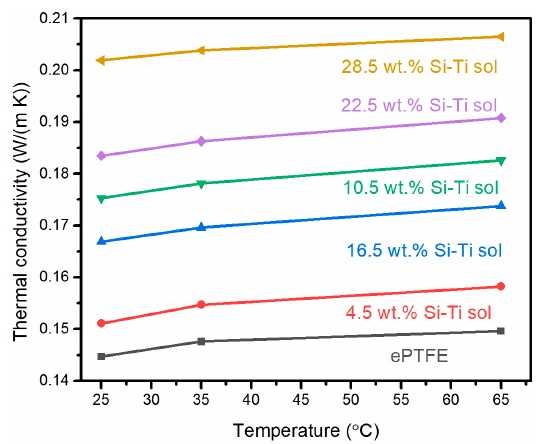
Figure 7 . The thermal conductivity of MSQ aerogel-layer-coated ePTFE film with different Si-Ti sol contents.